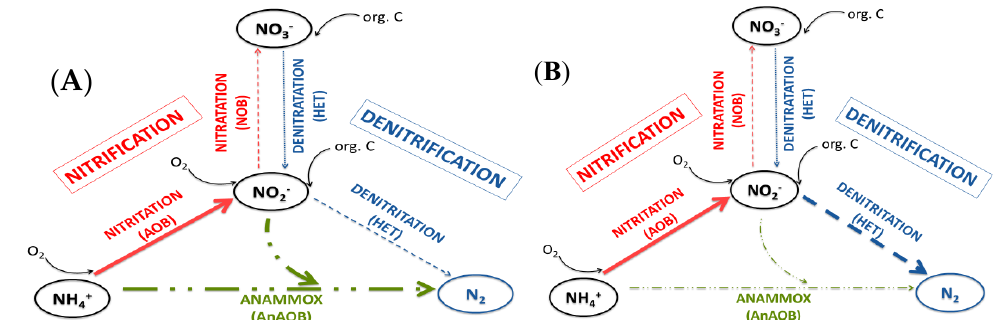
Figure 4. Key microbial groups involved in nitrogen metabolism and postulated nitrogen removal mechanisms in the biomass before ( A ) and after adaptation to the carbon source ( B ). AOB—ammonium oxidizing bacteria; AnAOB—anaerobic ammonium oxidizing bacteria; NOB—nitrite oxidizing bacteria; HET—heterotrophic denitrifiers.